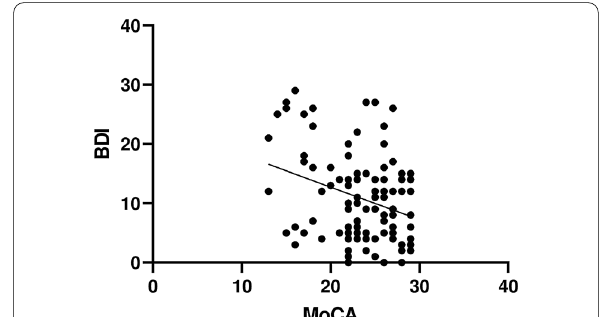
Fig. 4 The regression relationship between CI and depression severity in the group